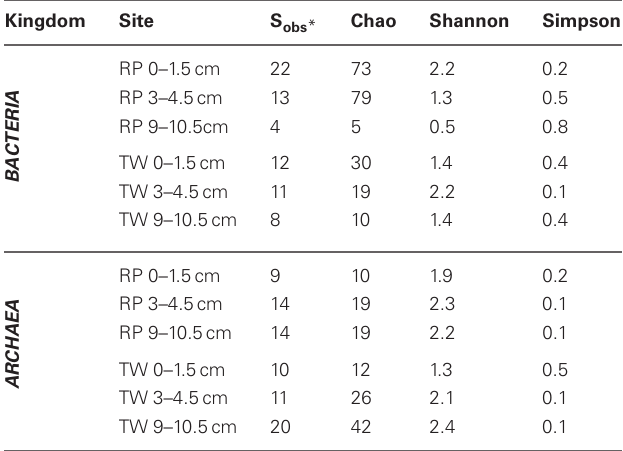
Table 3 | Microbial diversity richness indices for bacterial and archaeal depth profiles from RP and TW sites in Palaeochori Bay.